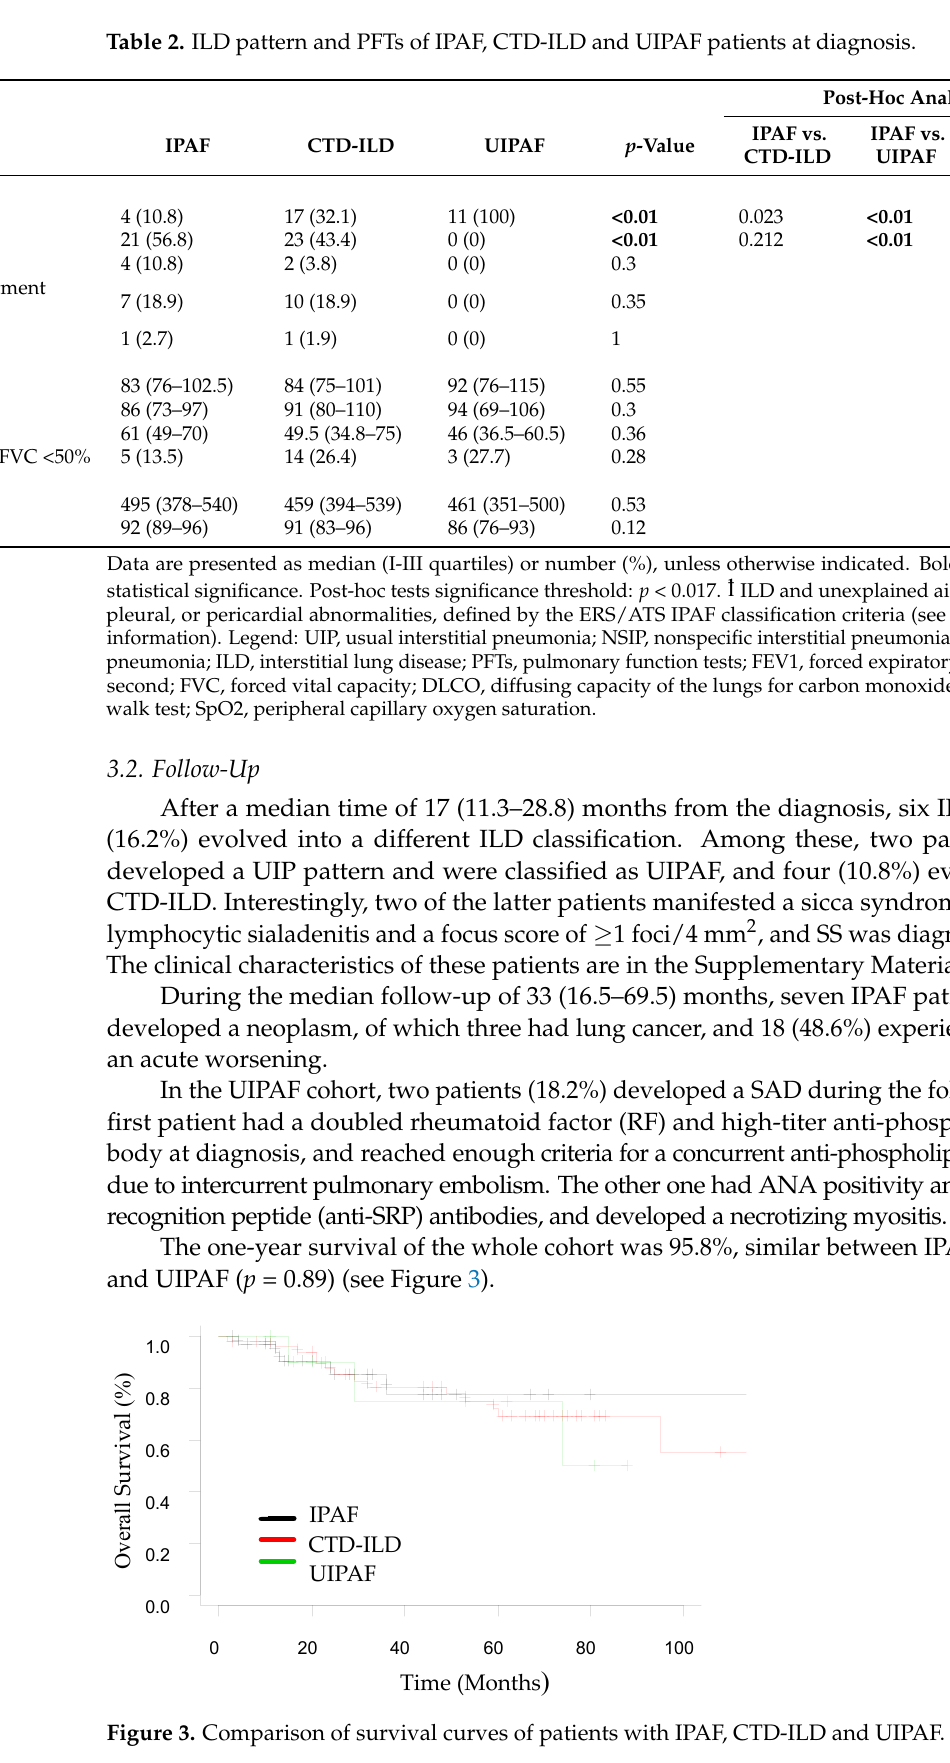
Table 2. ILD pattern and PFTs of IPAF, CTD-ILD and UIPAF patients at diagnosis.